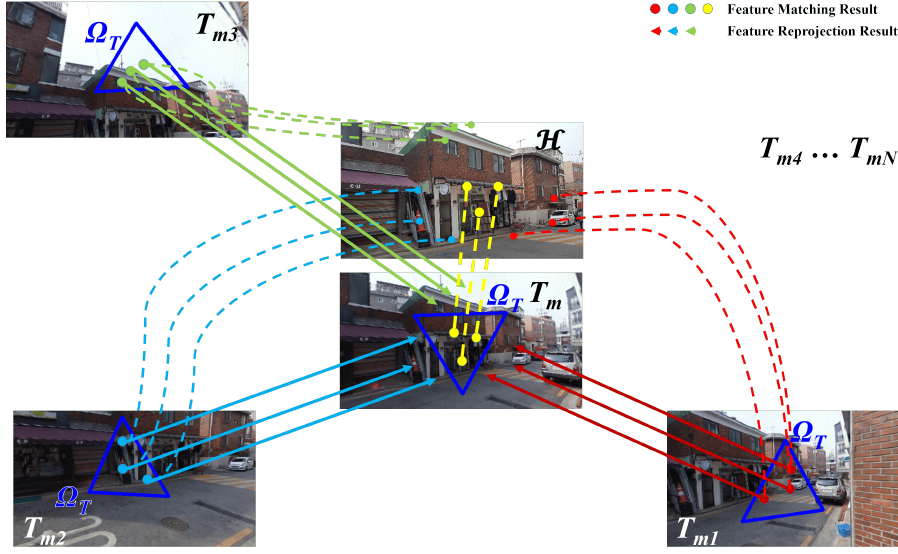
Figure 3. Feature reprojection process. As we extracted features on the tangent images (TIs) visibility region (i.e., triangle mask Ω T ), we only find matched features inside the Ω T when doing feature matching with the high angular resolution planar image (HPI) H . To find other matched features on the main tangent image (MTI) T m outside the Ω T , we reproject features from N neighboring tangent images (NTI) T m 1 , T m 2 , T m 3 , T m 4 ,... T mN to the MTI. We do not show the matching and reprojection process of NTI T m 4 ,... T mN for